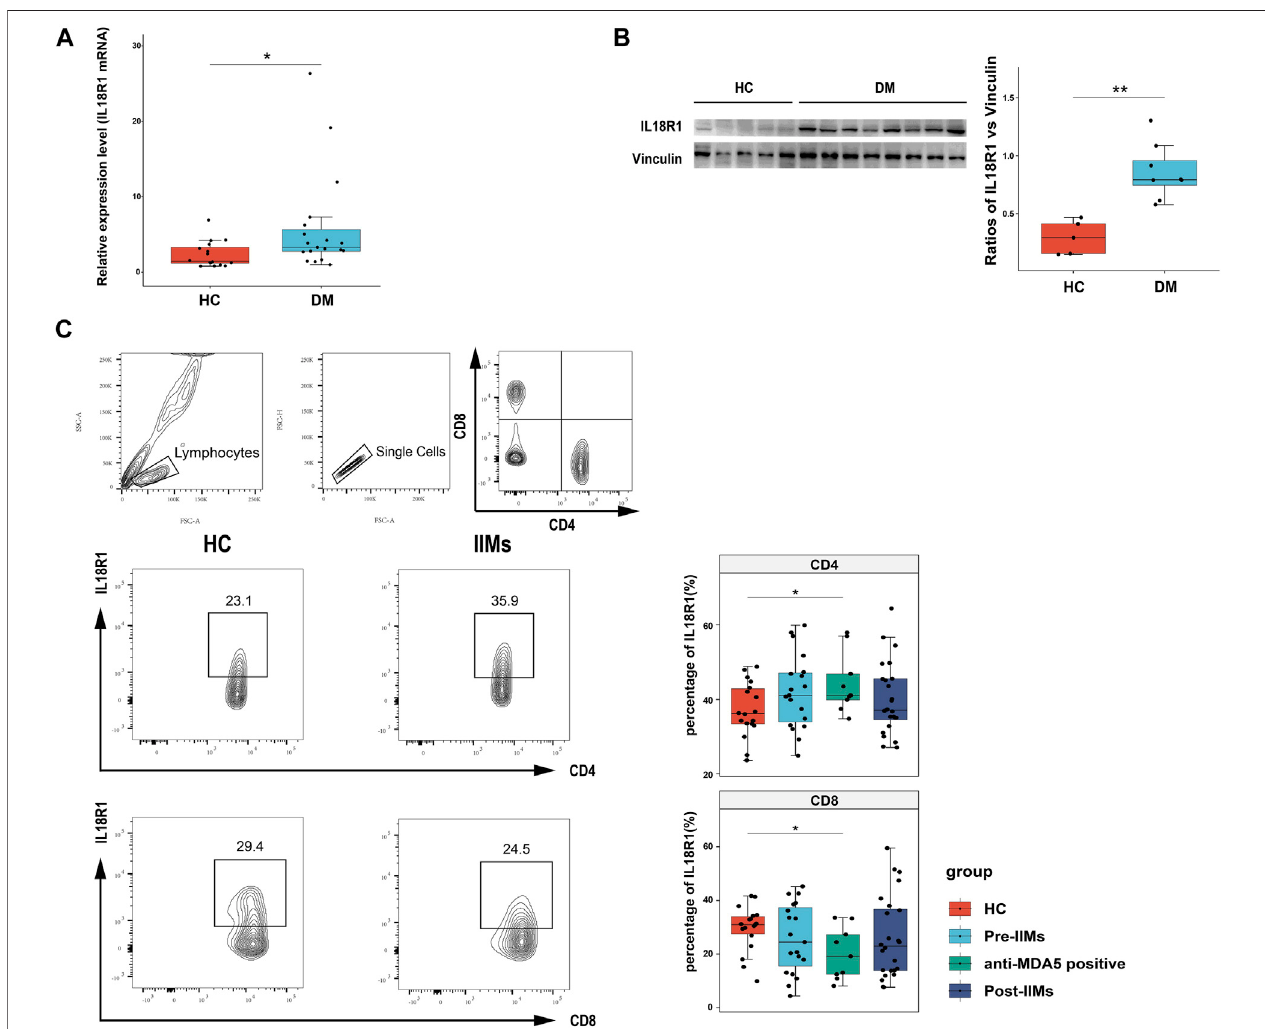
FIGURE4| ExpressionofIL18R1inthemuscletissuesandbloodofIIMspatients. (A) TheexpressionofIL18R1mRNAinthemuscletissuesof19DMpatientsand 16HC. (B) WesternblotshowedtheexpressionofIL18R1proteininmuscletissuesof8DMpatientsand5HC. (C) FlowcytometryanalysistheexpressionofIL18R1on lymphocytes among 19 untreated IIMs (9 anti-MDA5 positive) patients, 24 treated IIMs patients and 18 HC. Unpaired t -test was used for comparison. Pre-IIMs: IIMs before treatment; Post-IIMs: IIMs treatment. * p < 0.05, ** p < 0.01.